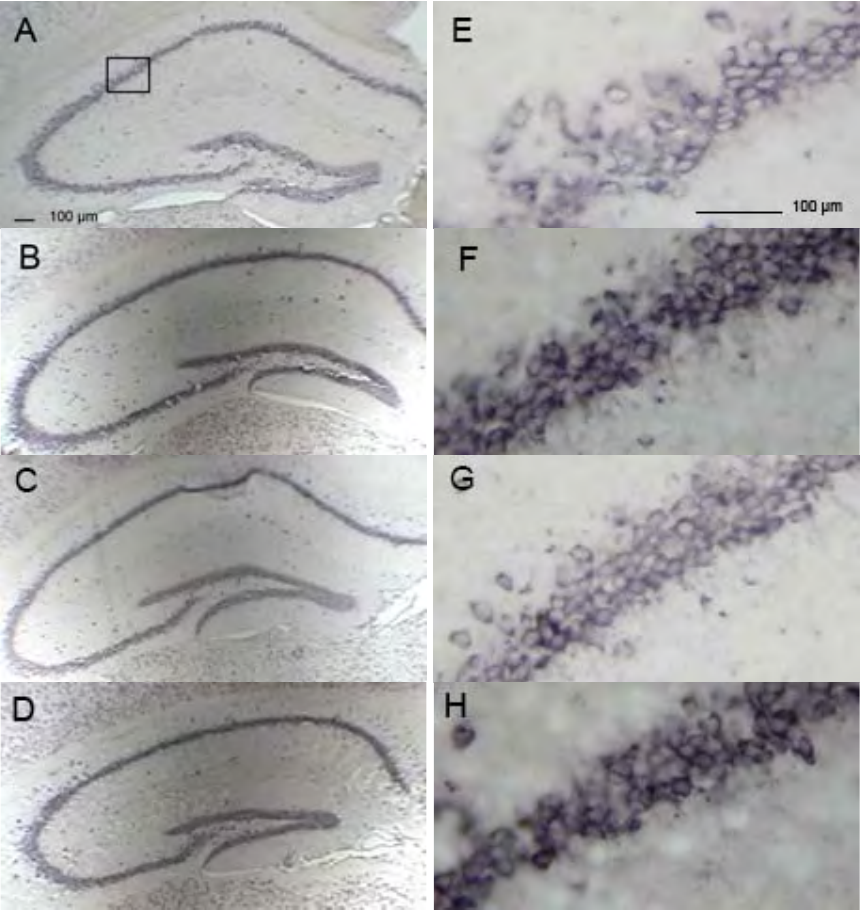
Figure 2 . Effects of daidzein on the expression levels of bcl-2 mRNA assessed by non- radioactive in situ hybridization in D-gal-treated mice hippocampus. (A) Aging control. (B) Vehicle control. (C) Da-10 group. (D) Da-5